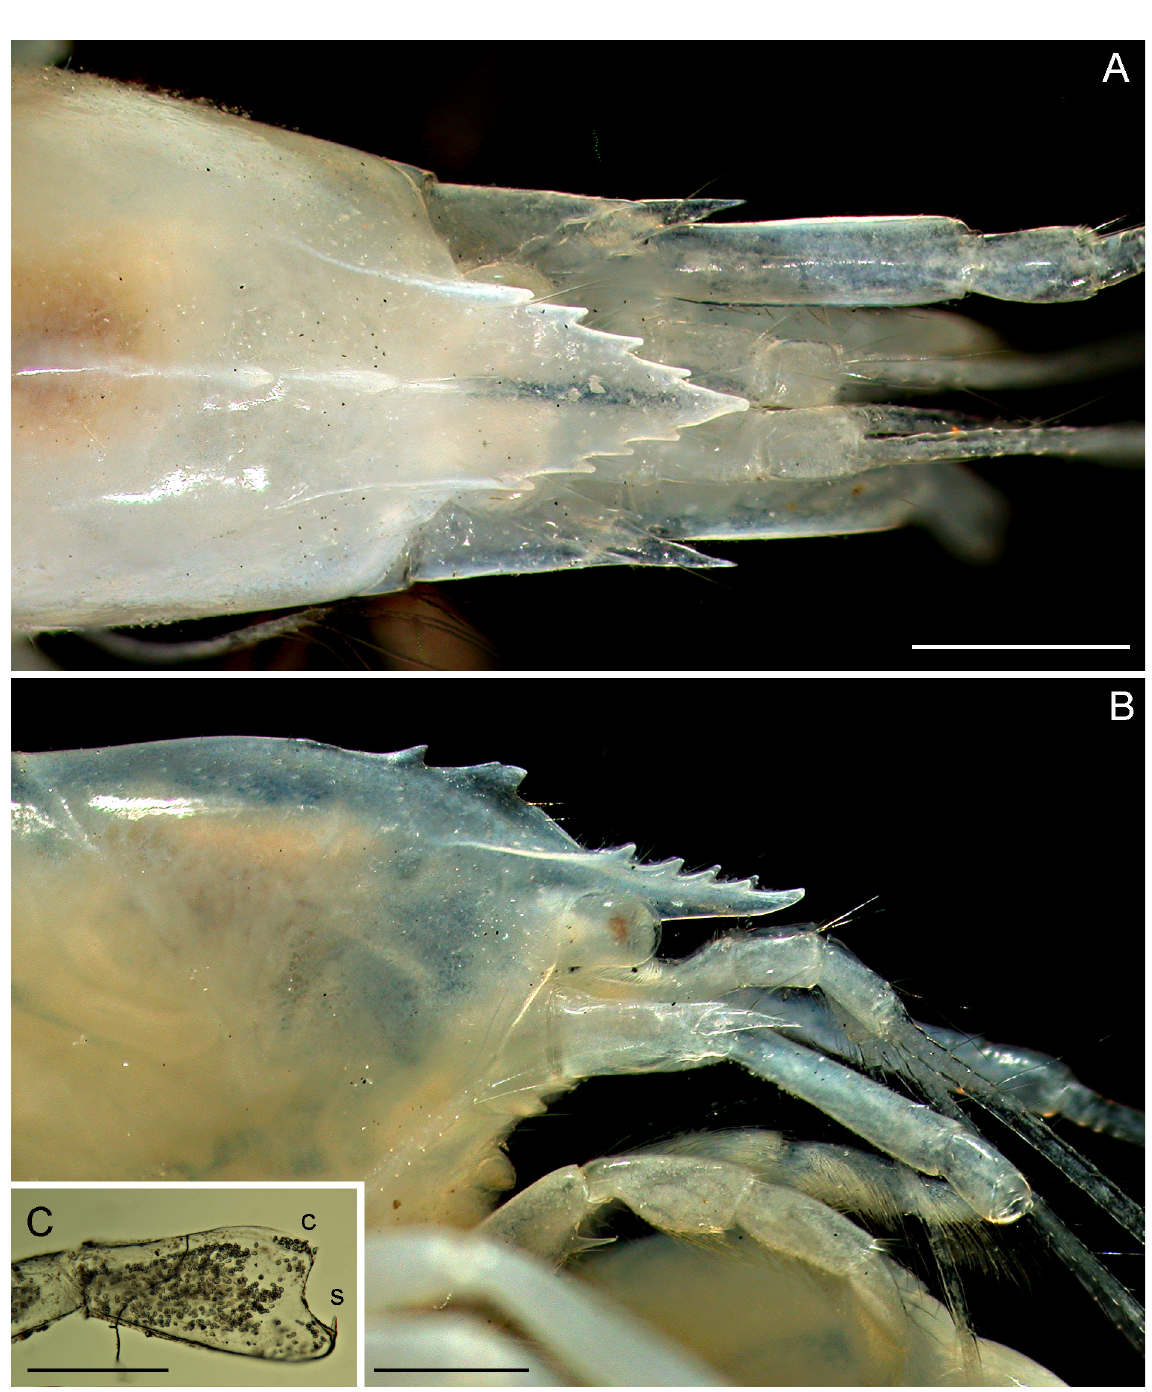
Fig. 4. Montanaxius mediumquod gen. et sp. nov., holotype, ♂, NHMW 25677. A . Front in dorsal view. B . Same in lateral view. C . Terminus of left first pleopod, posterior view. Abbreviations: c = cincinnuli (appendix interna); s = spine. Scale bars: A–B = 1 mm; C =